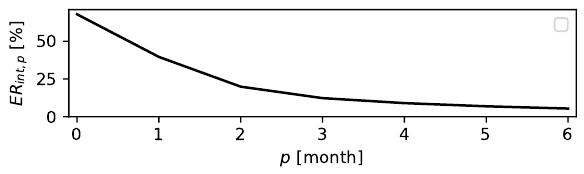
Figure 3. ER int,p for different allowed maximum errors p .